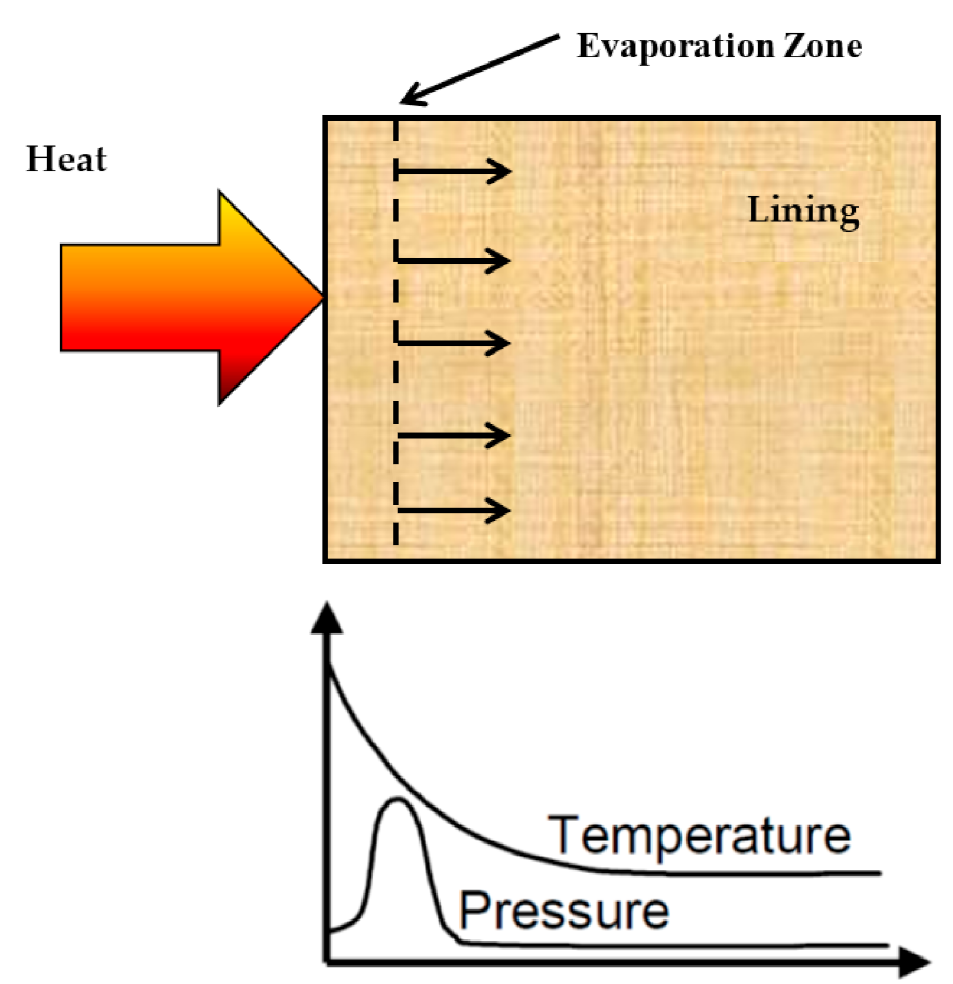
Figure 2. The process of buildup of steam pressure inside heated